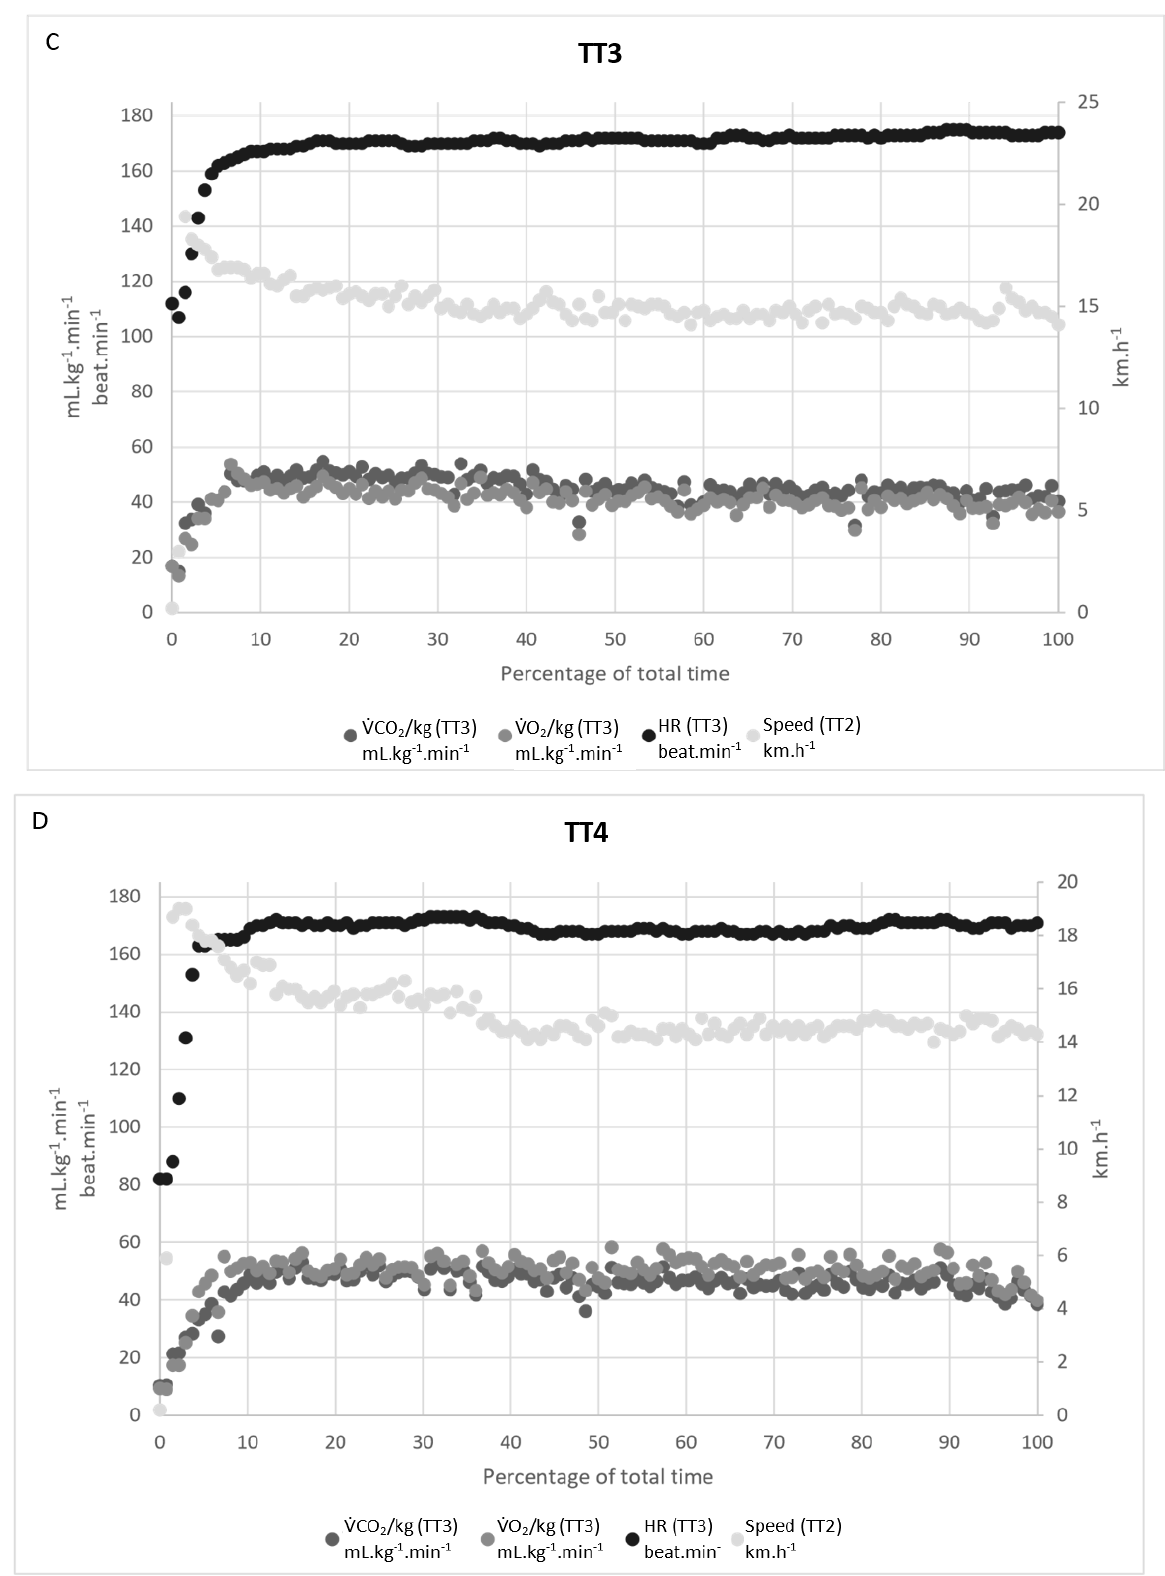
. VO 2 ) and carbon . VO 2 from TT1 (TT3),